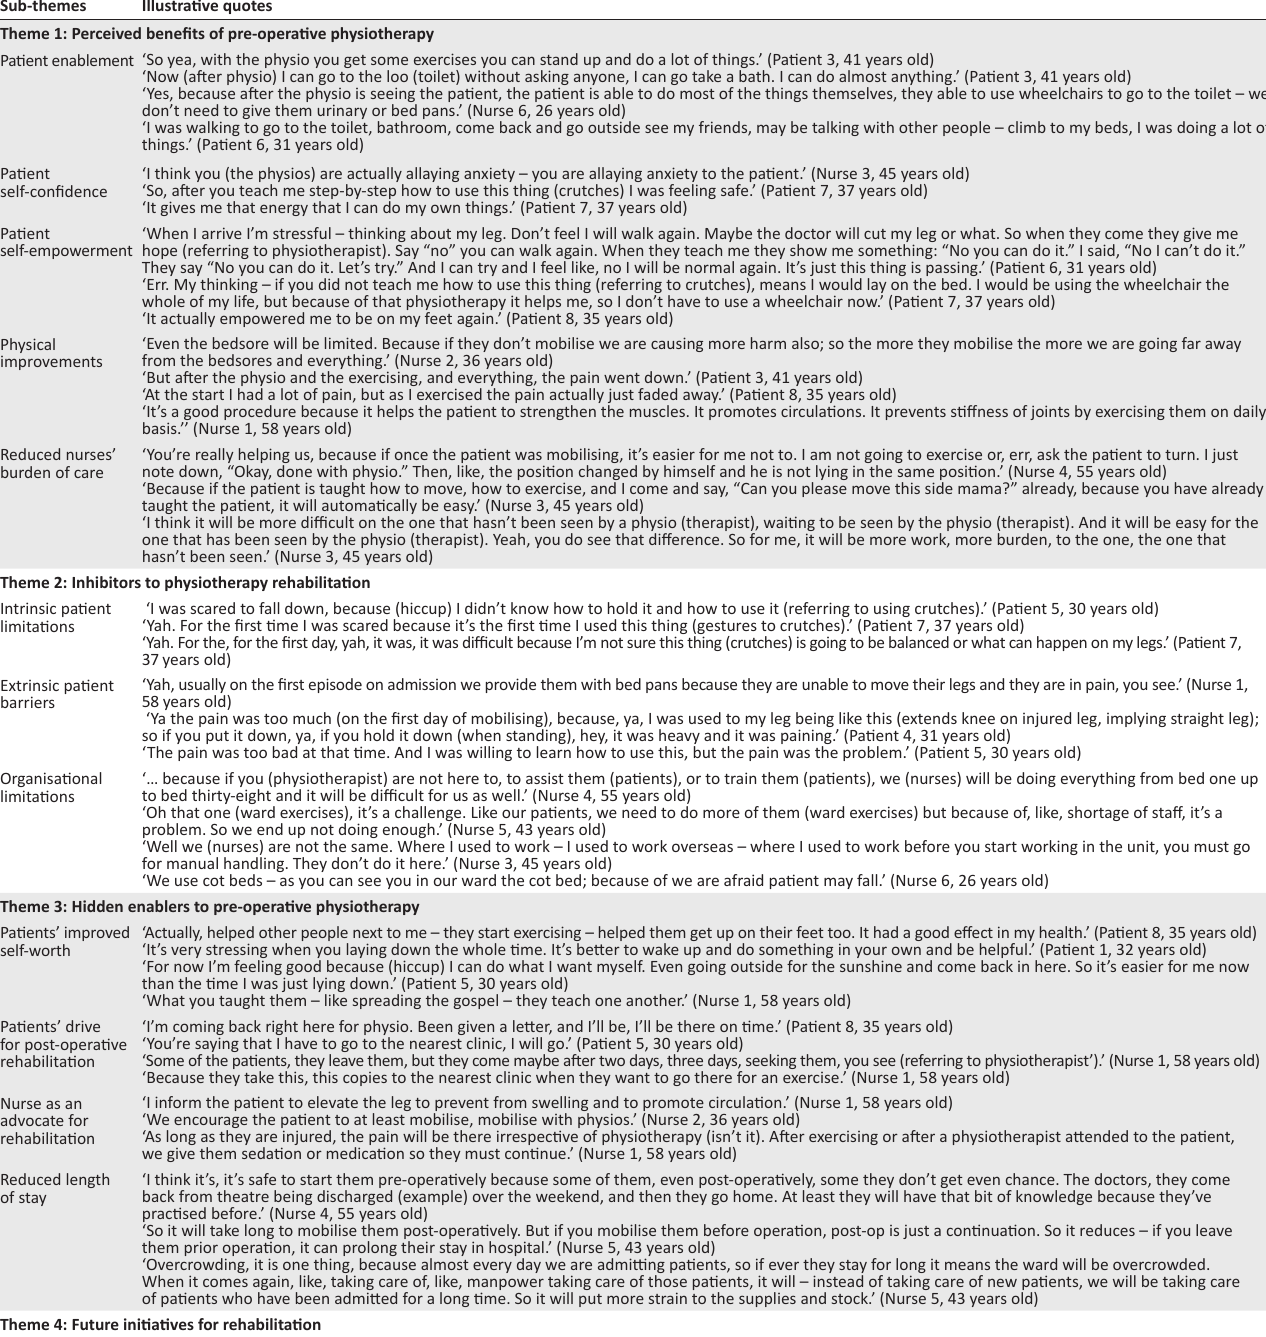
TABLE 1: Themes, sub-themes and illustrative quotes. Sub-themes Illustrative quotes Theme 1: Perceived benefits of pre-operative